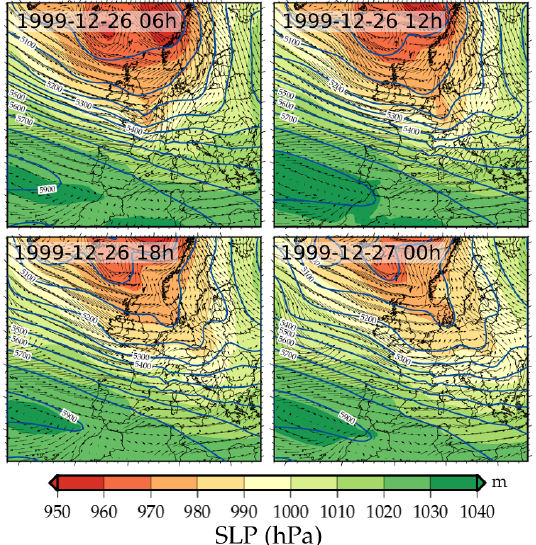
Figure 3. Synoptic situation of storm Lothar: colour shading depicts the sea level pressure, whereas blue contours indicate the geopo- tential height at 500hPa. The arrows represent 10ms − 1 wind. The fields represent consecutive snapshots for the period of most severe wind speeds between 26 December, 06:00UTC and 27 December, 00:00UTC in steps of 6h (see Fig. 4). The data fields are obtained from the ERA-Interim reanalysis, the same used to drive the RCM